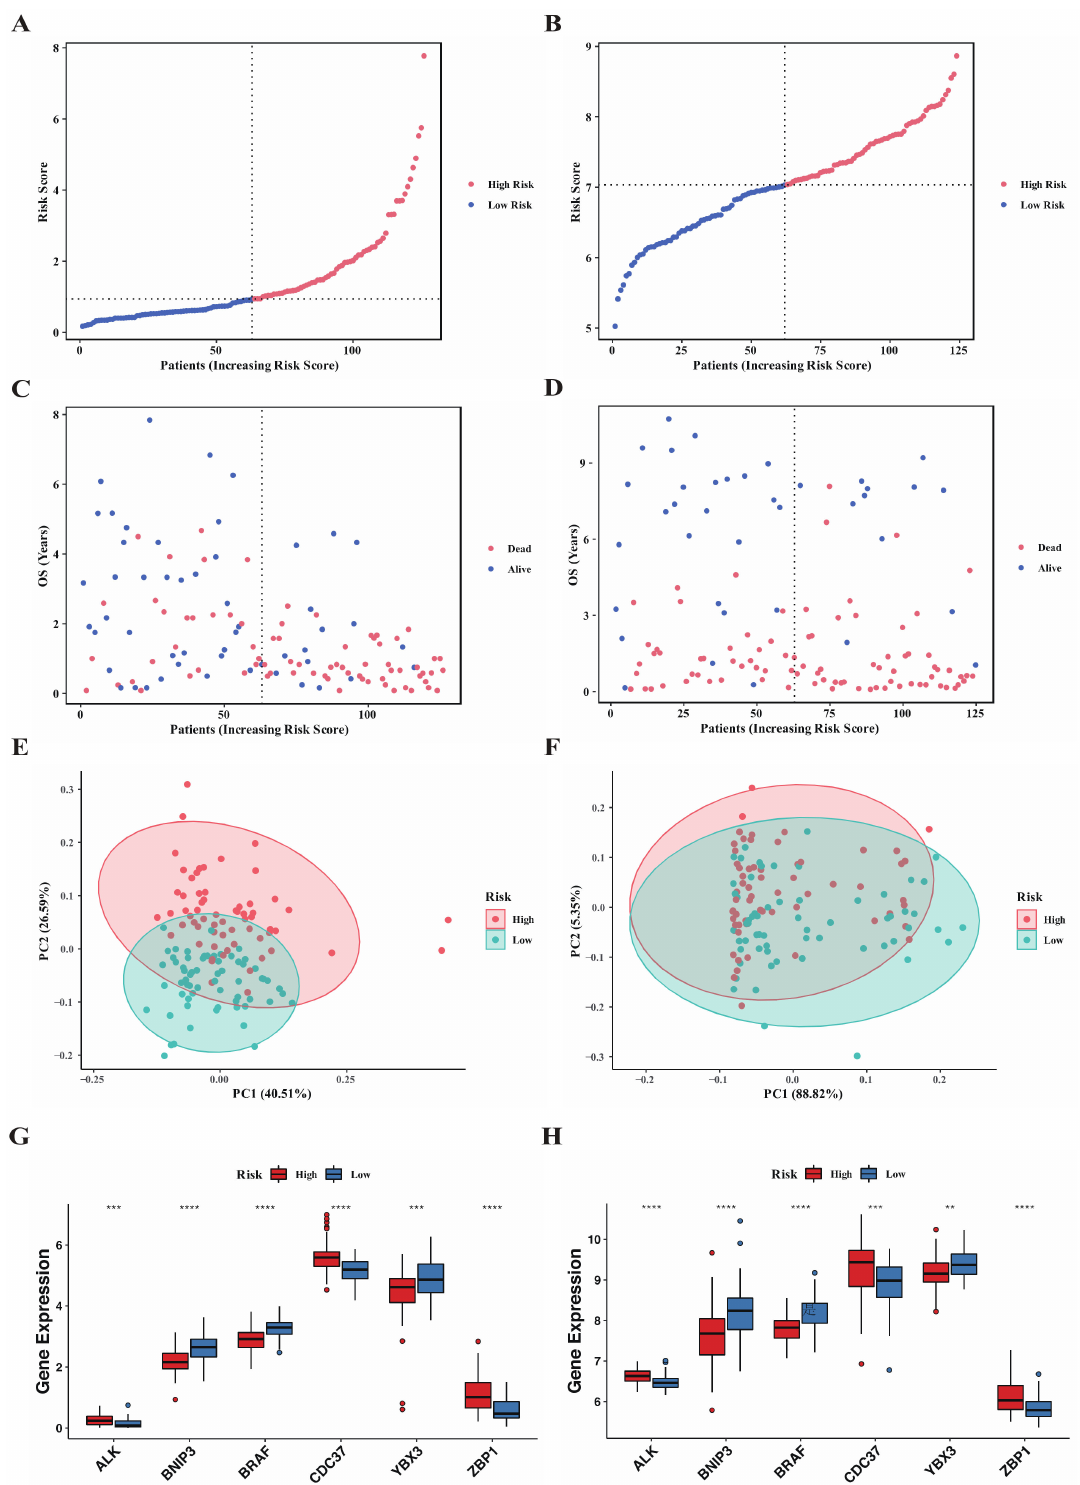
Figure 4. Two risk subgroups generated based on the median risk score. ( A – D ) Distribution of risk score, survival time and survival status for AML patients in TCGA cohort ( A , C ) and GSE37642 cohort ( B , D ). ( E , F ) Principal component analysis of the risk score to distinguish the two subgroups in TCGA cohort ( E ) and GSE37642 cohort ( F ). ( G , H ) Comparison of the expression of 6 genes in the risk model between the two subgroups in TCGA cohort ( G ) and GSE37642 cohort ( H ). (Wilcox test, ** p < 0.01; *** p < 0.001, **** p